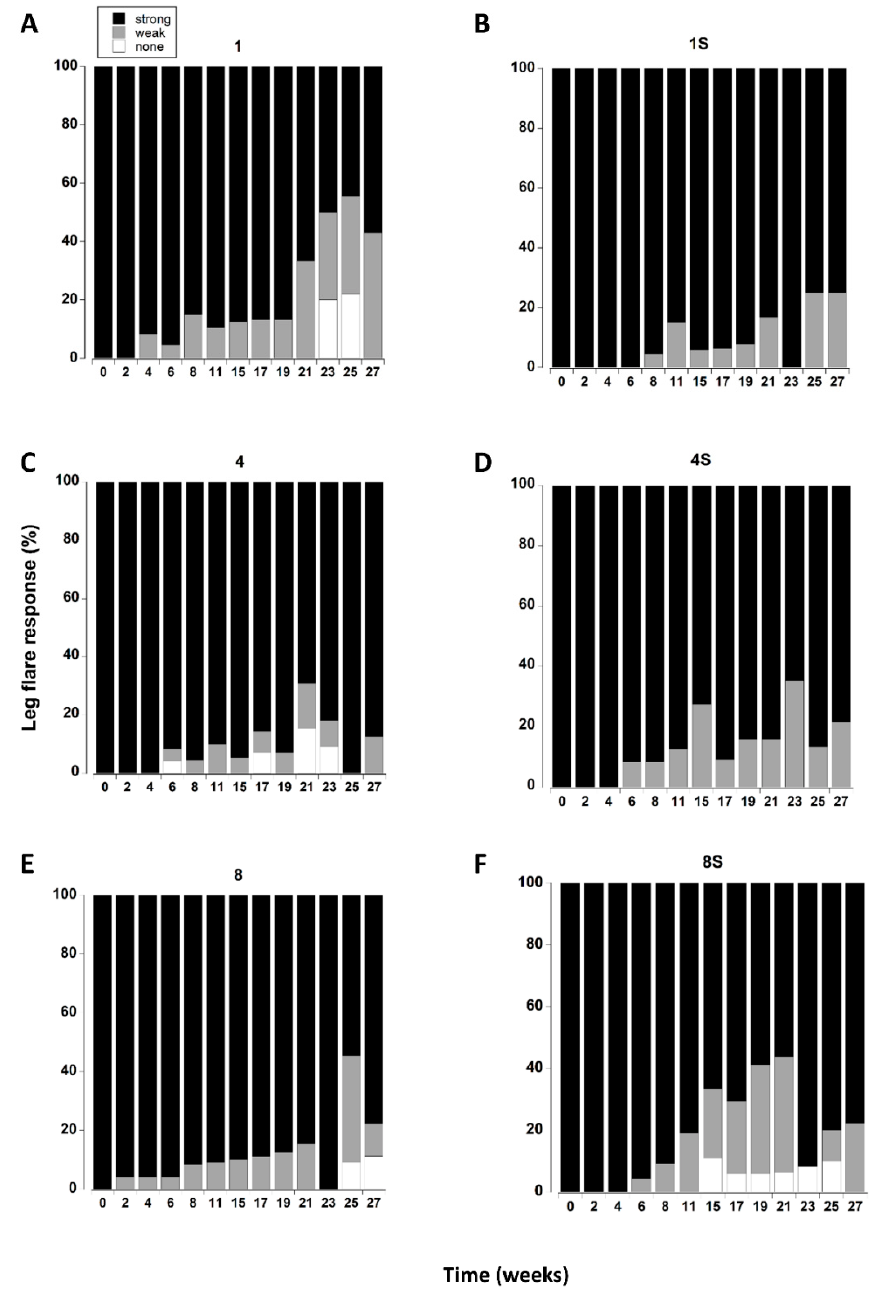
Figure 6. ( A – F ). Leg flare responses of C. maenas (mean ± SE) kept in densities of 1, 4 or 8 crabs, with (S) or without shelter. The flare response was classified as strong, weak or absent (Table 1) and expressed as a percentage of animals alive at each time period. If a crab died or lost both of its fourth pair of walking legs, or lost > 3 legs on one side it was not included in the measurements.